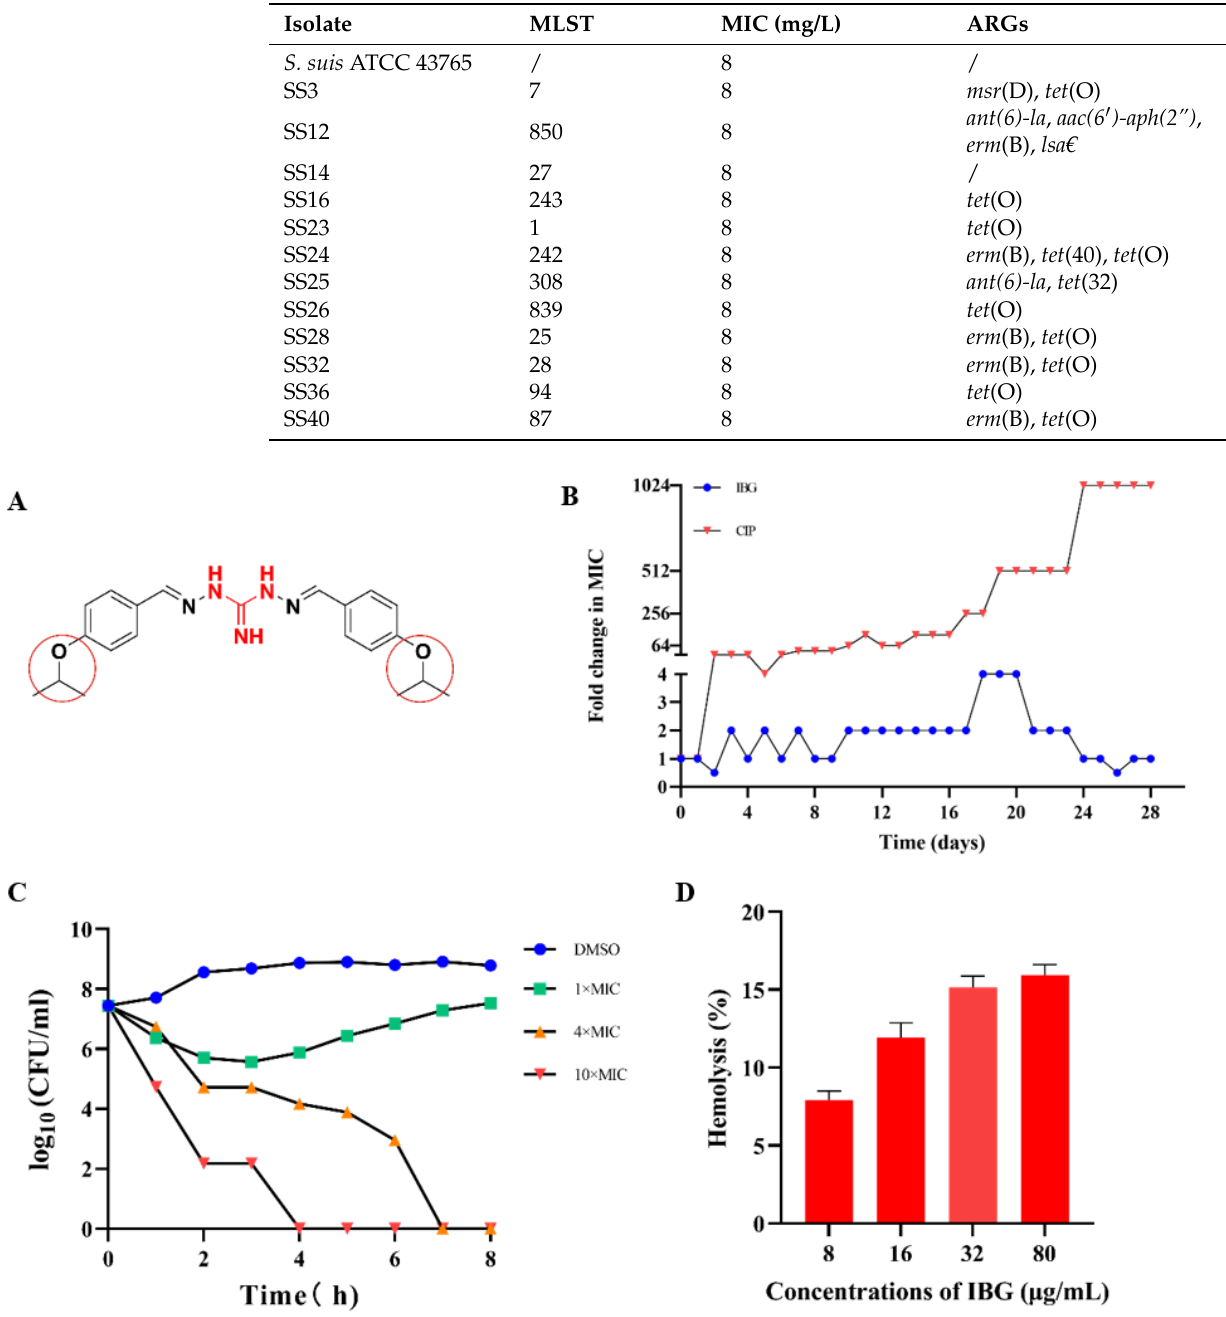
Table 1. Activity of IBG against a wide variety of MLST S. suis . MLST, multi-locus sequence type; MIC, minimum inhibitory concentration; /, none.